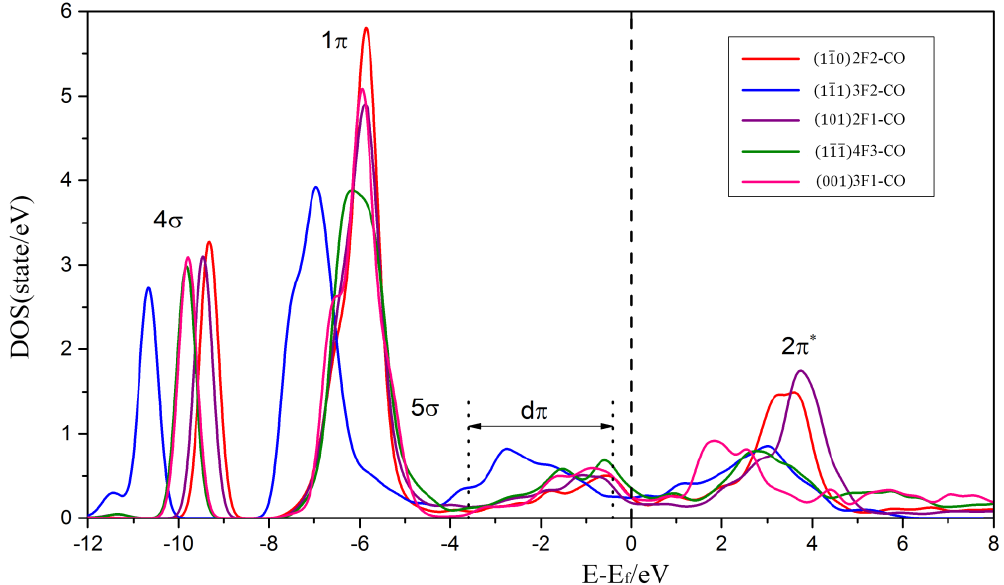
(cid:16) (cid:17) (cid:16) (cid:17) (cid:16) (cid:17) 110 2F2, 111 3F2, ( 101 ) 2F1, 111 4F3